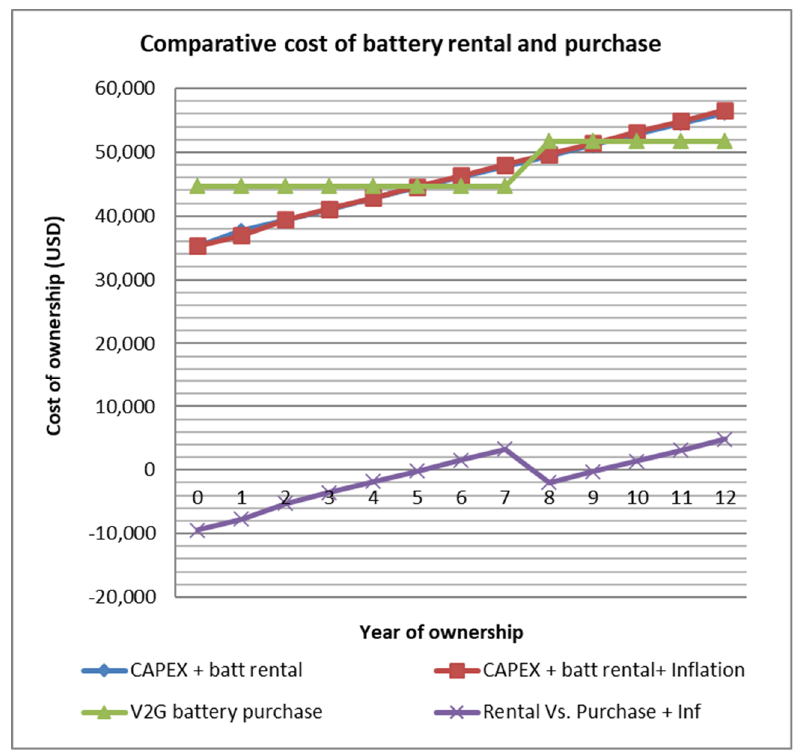
Figure 8. Graphical representation of battery rental costs versus battery purchase ones.